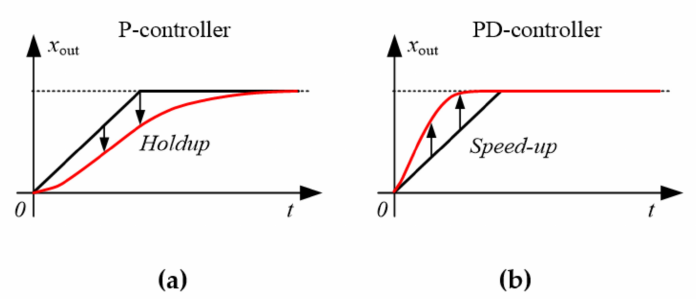
Figure 8. Time diagrams of the output signal of a closed loop with a proportional controller—( a ) and proportional and differential controller—( b